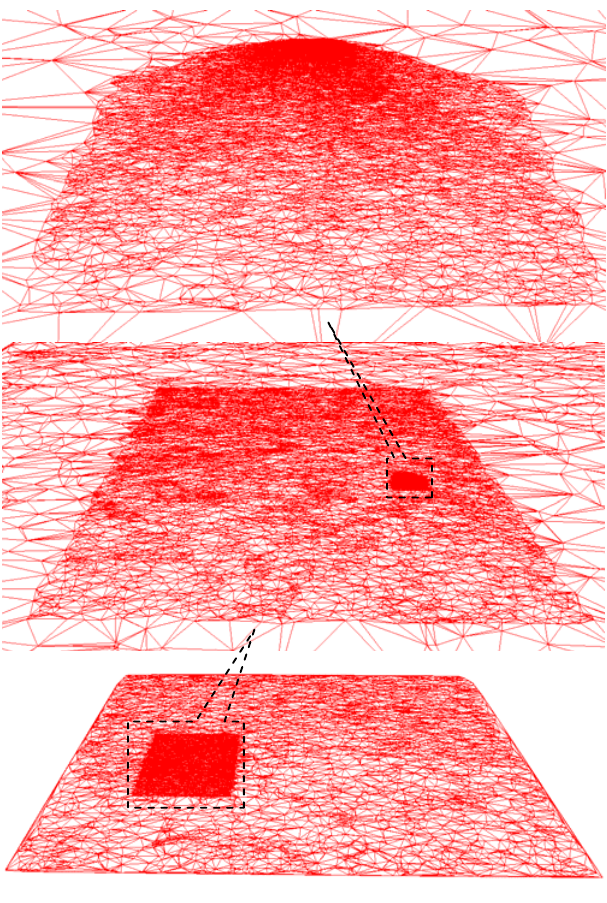
Figure 7. A unified, integrated TIN at the CE-3 landing site. The top, middle and bottom figure show the TINs of descent images, No.0236 and No.0570 images,